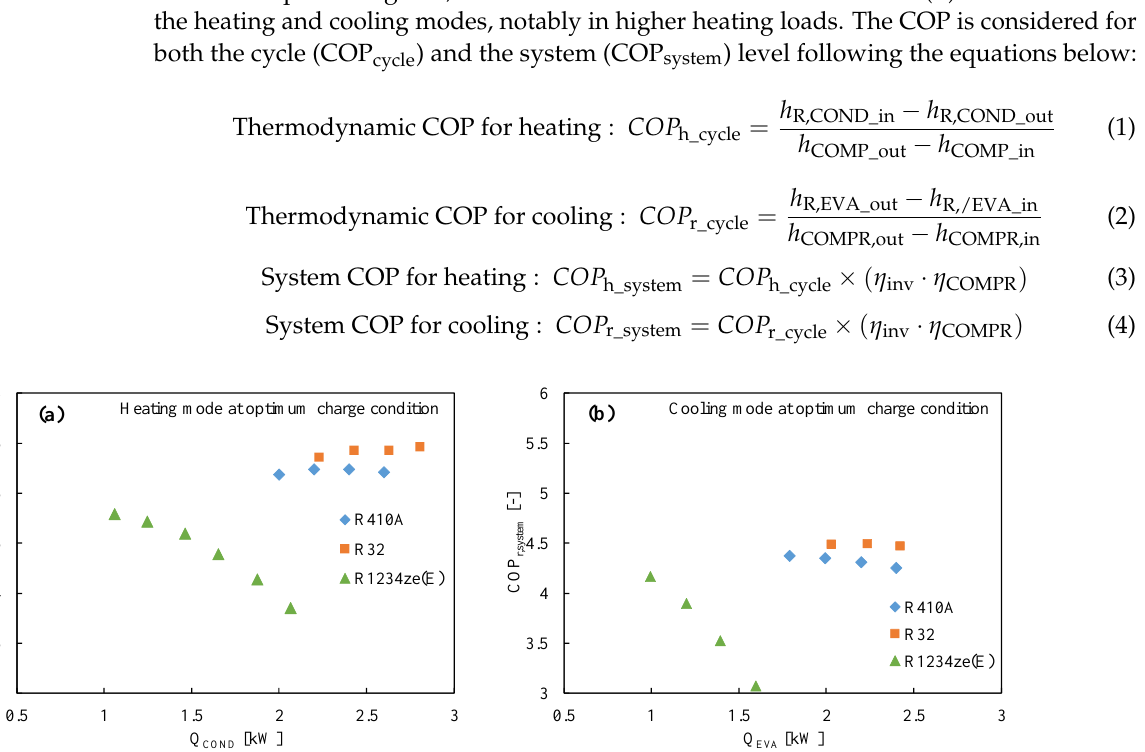
R152a (1,1 difluoroethane, C 2 H 4 F 2 ) has been considered as a refrigerant blend for a long time, but not as a pure refrigerant. The refrigerant ’ s critical pressure and tempera- ture are 4.52 MPa and 115 °C, respectively [77 – 79]. It does not have any ODP. Compared to the HFC and HFO refrigerants, R152a has a low global warming potential (138 [80]) and a lower price. The volumetric capacity and pressure of R152a are quite close to those of R134a. On the other hand, the energy efficiency, mass flow, and vapor density are much better than those of R134a [81]. The system performance in a vapor compression system was found to be higher than that of R134a [27,82]. Test results demonstrated a 4.7 – 13% improvement in the COP, with a decrease in the cooling capacity of about 0 – 10%. Figure 3 shows the comparison of the (a) COP and (b) energy consumption be-